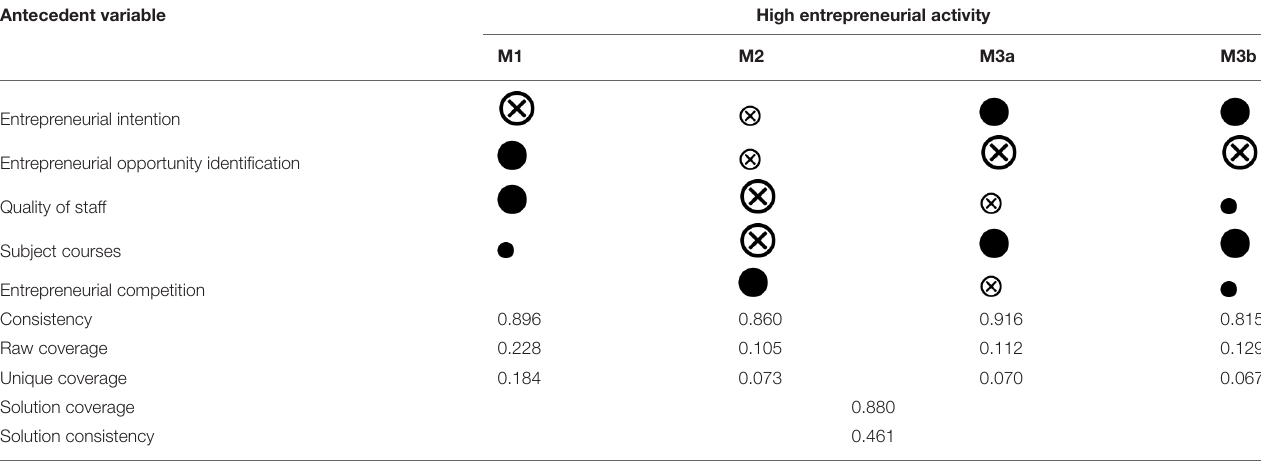
Attached Table 1. Robustness test for increasing the frequency threshold. Antecedent